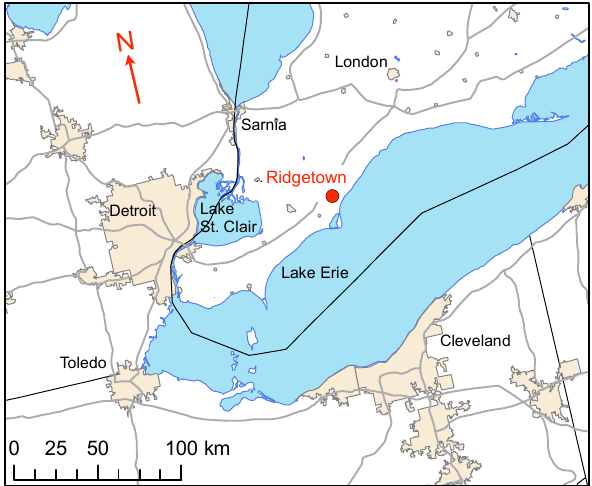
Fig. 1. BAQS-Met field study Ridgetown supersite and other areas of interest in southwestern Ontario and adjacent areas in the